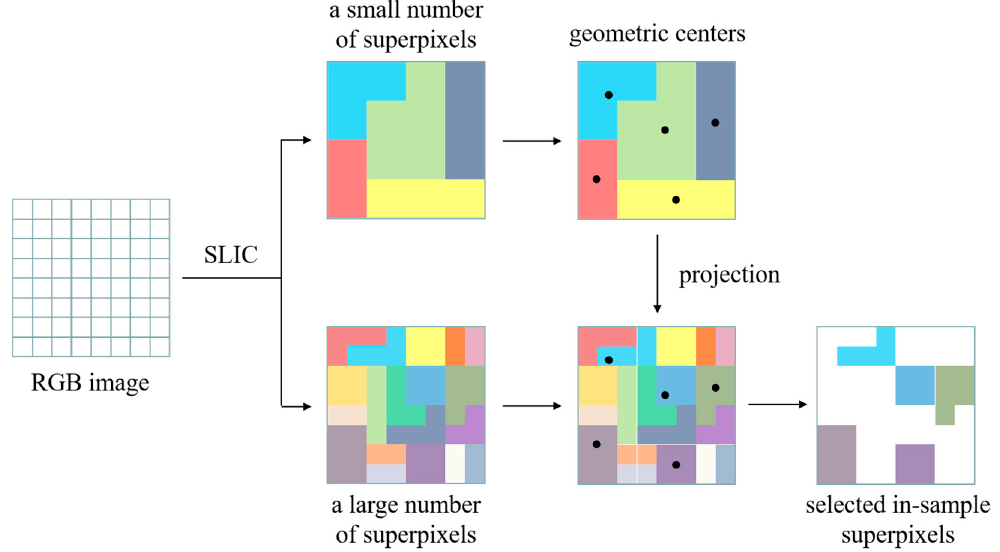
Figure 2. Architecture of proposed superpixel-based selection method of in-sample data.